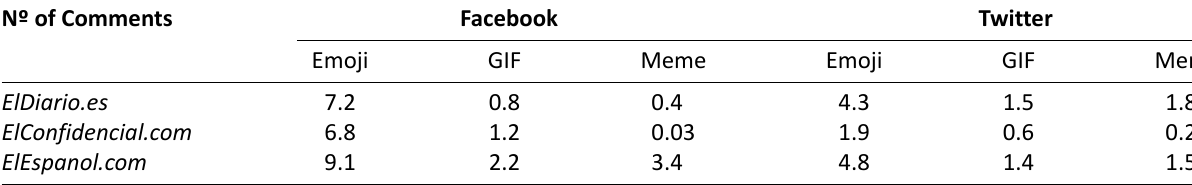
Table 4. Presence of digital discourse language elements on social networks (%). Nº of Comments